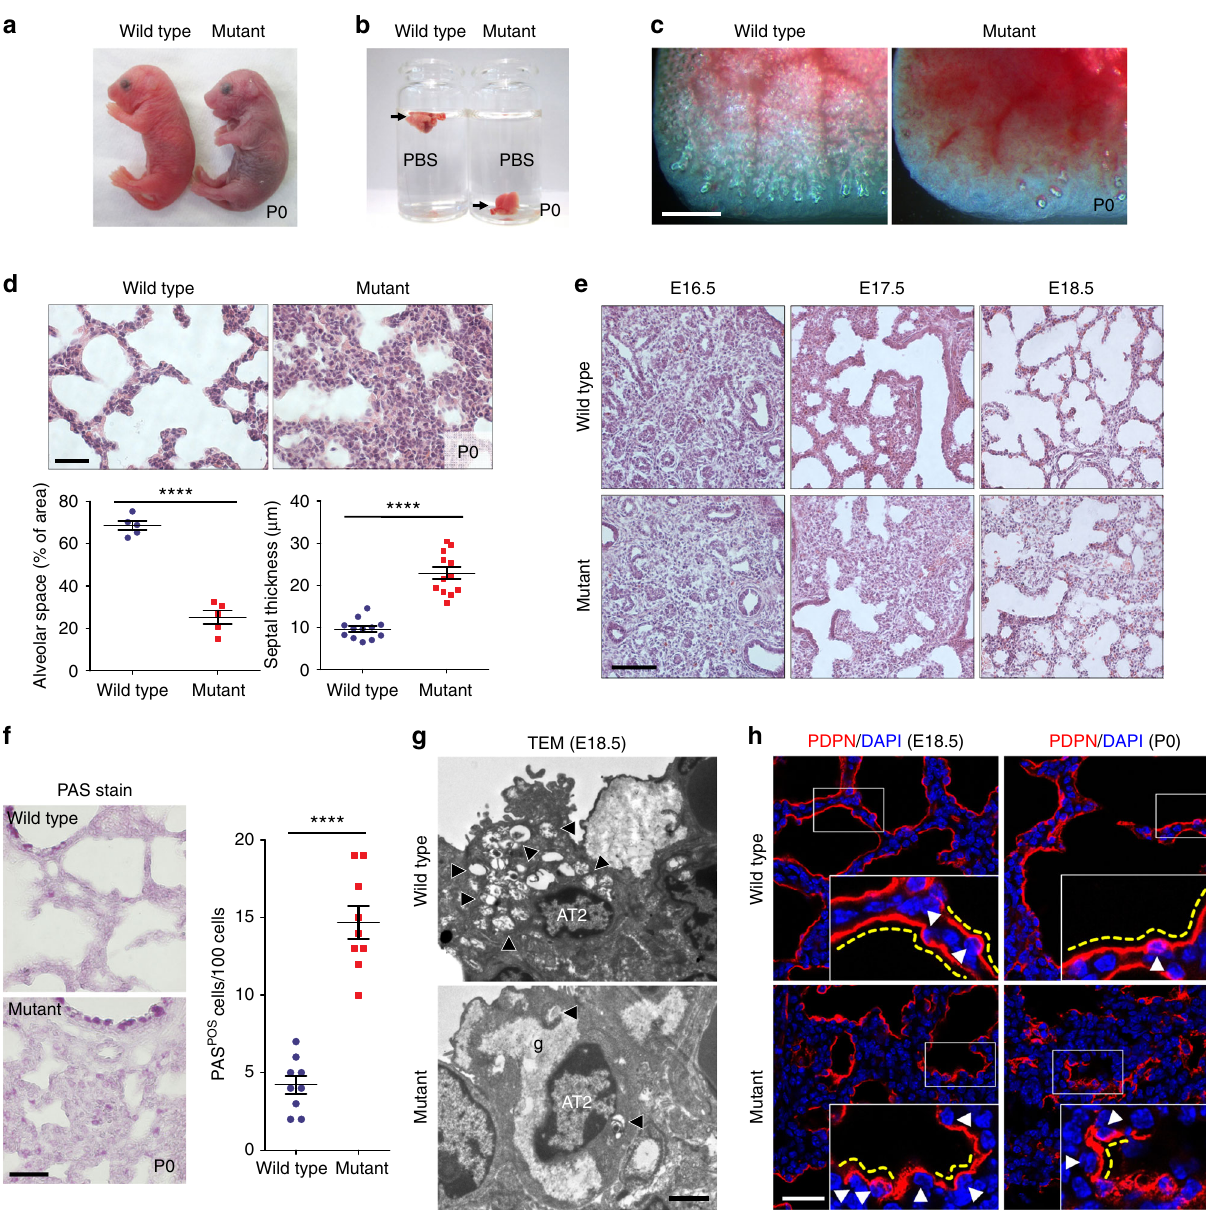
Fig. 1 The ENU-induced mutant exhibits lung development defects. a Gross morphology of wild-type ( n = 15) and mutant ( n = 12) P0 mice. b Floating assay for wild-type ( n = 10) and mutant ( n = 8) P0 lungs. c Representative pictures of distal lung from wild-type ( n = 10) and mutant ( n = 8) P0 mice. d Hematoxylin and eosin (H&E) staining and morphometric analysis of alveolar space and septal thickness in wild-type ( n = 15) and mutant ( n = 10) P0 lungs. e H&E staining of wild-type ( n = 6 for each stage) and mutant ( n = 5 for each stage) lungs at E16.5, E17.5, and E18.5. f PAS staining ( n = 15 wild types, n = 10 mutants) and phenotype quanti fi cation at P0. g Representative TEM images of AT2 cells in wild-type ( n = 3) and mutant ( n = 3) lungs at E18.5. Arrowheads point to lamellar bodies in AT2 cells; g glycogen. h Immunostaining for PDPN in wild-type ( n = 8 per each stage) and mutant ( n = 8 per each stage) lungs at E18.5 and P0. Arrowheads point to AT1 nuclei; yellow dotted lines outline AT1 cell morphology. Error bars are means± s.e.m. **** P < 0.0001, two-tailed Student ’ s t -test. Scale bars: 500 μ m ( c ), 50 μ m ( d , e ), 30 μ m ( f , h ), 2 μ m ( g genotyping 102 G4 and G5 mutant mice and found complete association between the lung phenotype and the Myh10 mutation Myc appeared dissociated from the actin bundles of stress fi bers (Figs. 2b, c). We then performed a complementation test between (Supplementary Fig. 3c). To quantify the expression levels of the ENU-induced Myh10 mutant and a Myh10 null allele 22 . Myh10 mRNA and protein in the P0 mutant lungs, we Trans-heterozygous mice exhibited the same lung and heart used reverse transcriptase-quantitative PCR (RT-qPCR), western phenotypes as the Myh10 global 27,28 and ENU-induced mutants, blotting, and immunostaining. Expression of Myh10 mRNA was indicating that the loss of Myh10 function is responsible for the not signi fi cantly altered in Myh10 L458R/L458R (hereafter Myh10 -/- ) lungs compared with Myh10 + / + and Myh10 + /L458R (hereafter lung phenotype (Supplementary Fig. 3a, b). In addition, the localization of MYH10 L458R was different than that of MYH10 WT Myh10 + /- ) lungs. However, MYH10 protein expression was dramatically reduced in Myh10 -/- lungs compared with in cultured fi broblasts: while MYH10 WT -Myc was localized as